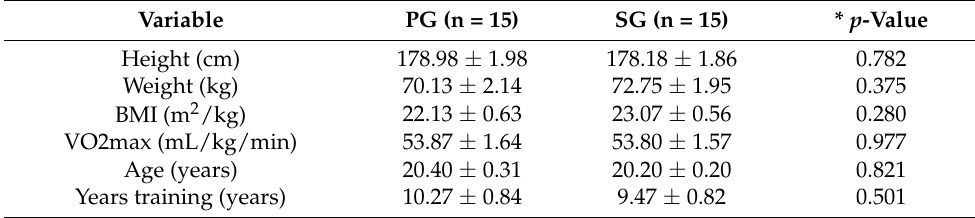
Table 1. Study participant characteristics.